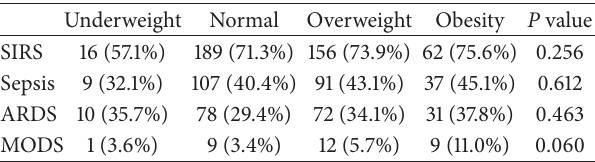
Table 4: Clinical complications according to the BMI. Underweight Normal Overweight Obesity P value